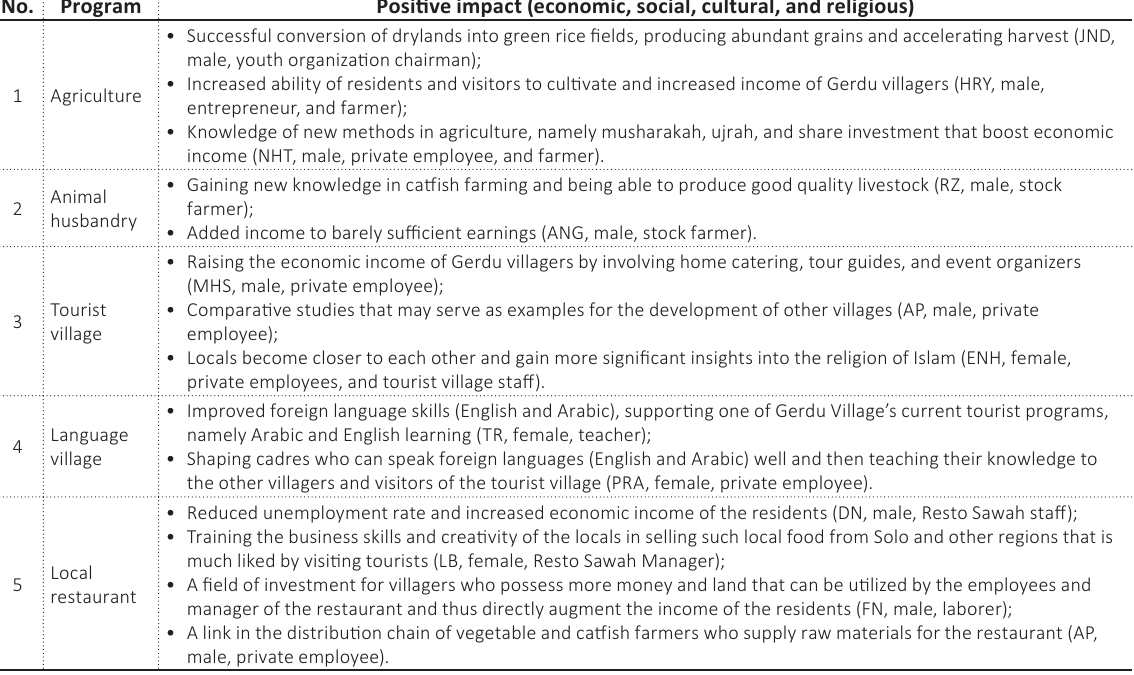
Table 4. The positive impact of sharia economic implementation in Gerdu Village No.